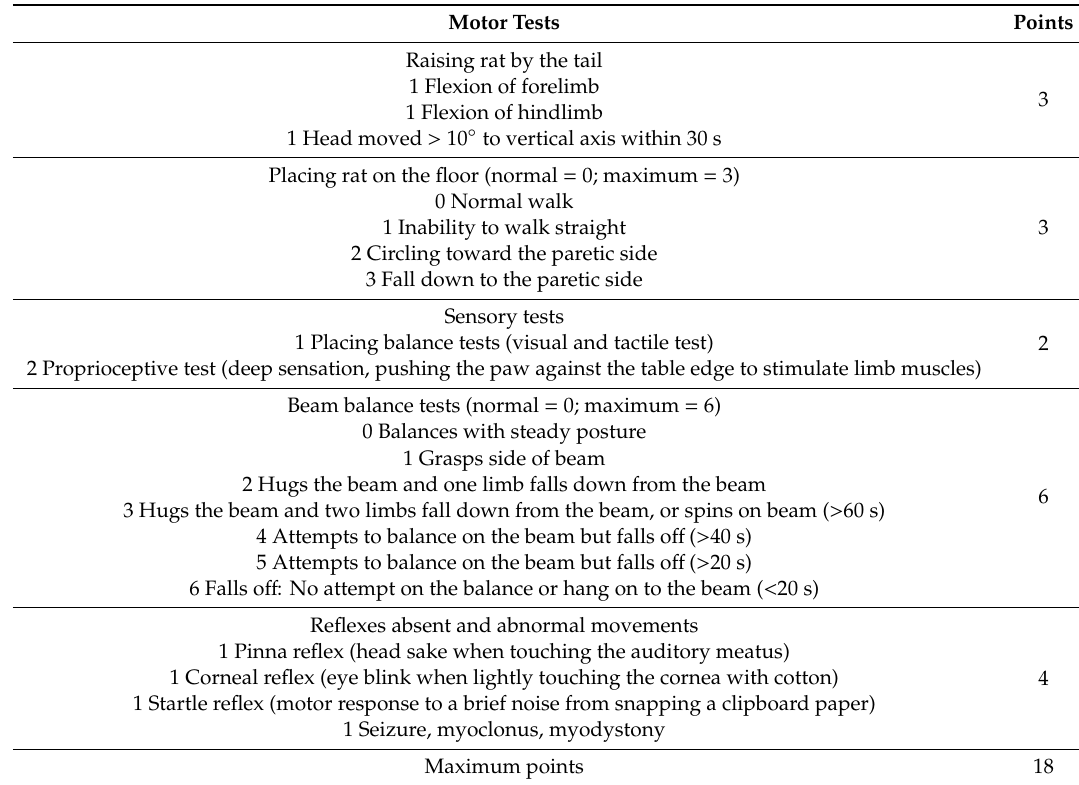
Table 1. Neurological severity